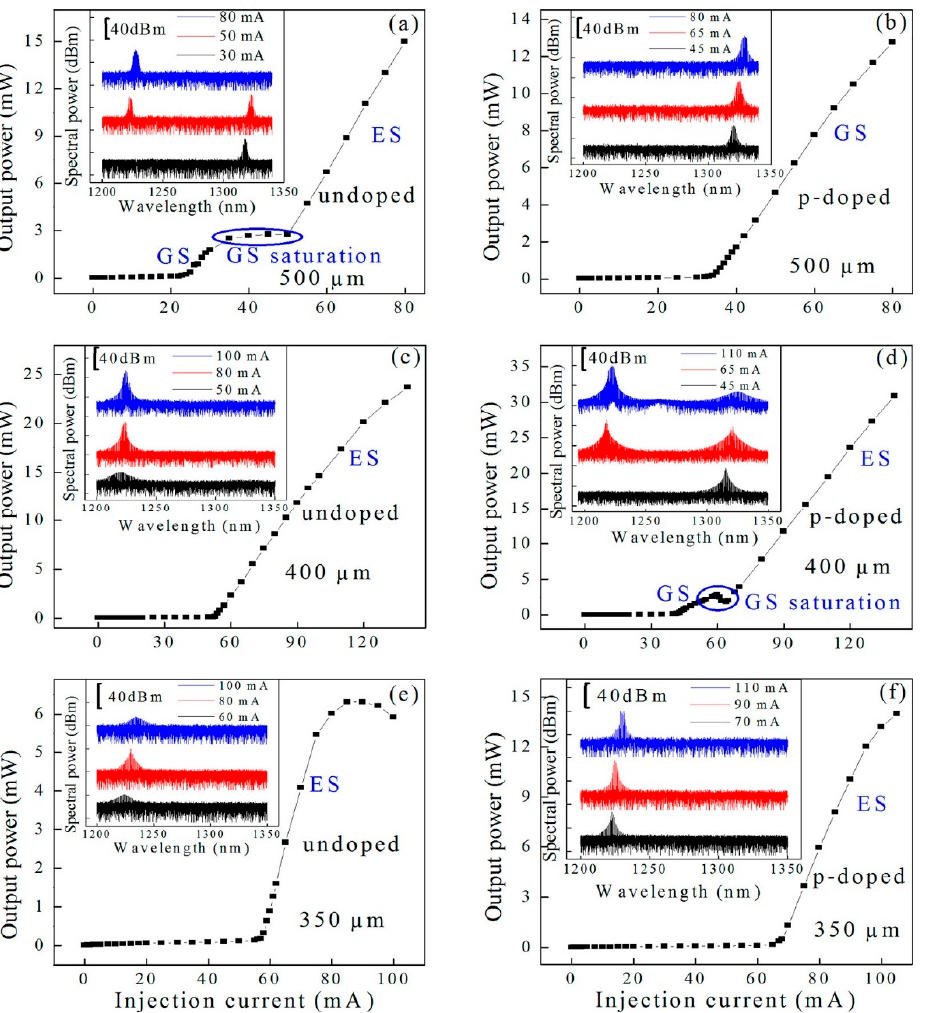
Figure 17. P-I characteristics with different L for QDU and QDP lasers. ( a , c , e ) for QDU lasers with 500, 400, and 350 μ m; ( b , d , f ) for QDP lasers with 500, 400, and 350 μ m, respectively. Inset: Corresponding lasing spectra of the device under various injection currents. Reproduced with permission from [78]. American Chemical Society, 2018.